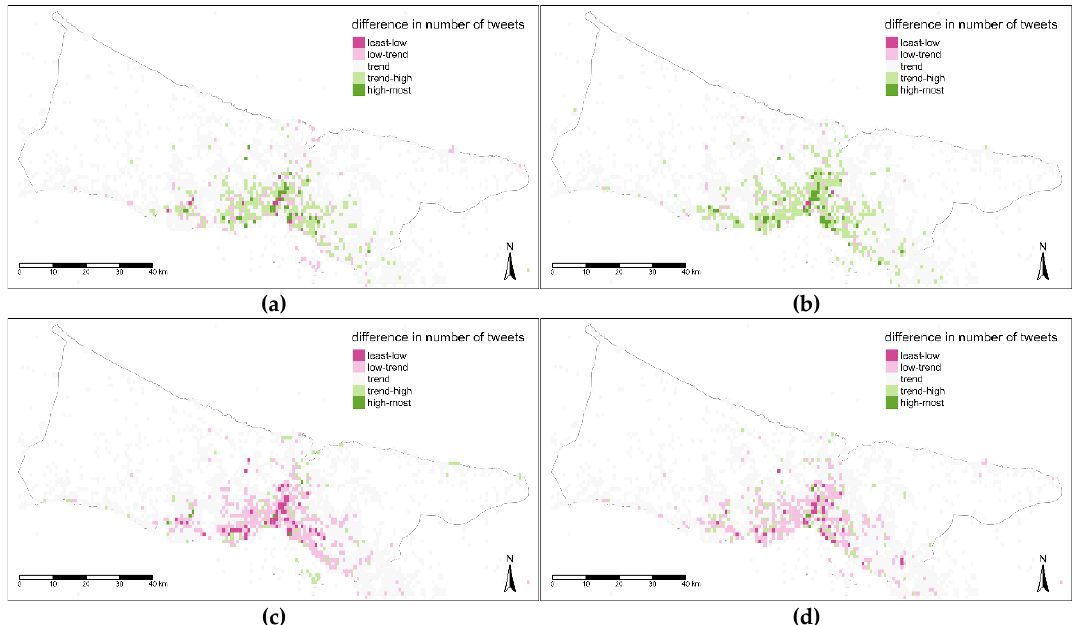
Figure 16. Spatiotemporal Bias for Temporal Level-3 ( a ) Winter; ( b ) Spring; ( c ) Summer; ( d ) Autumn.